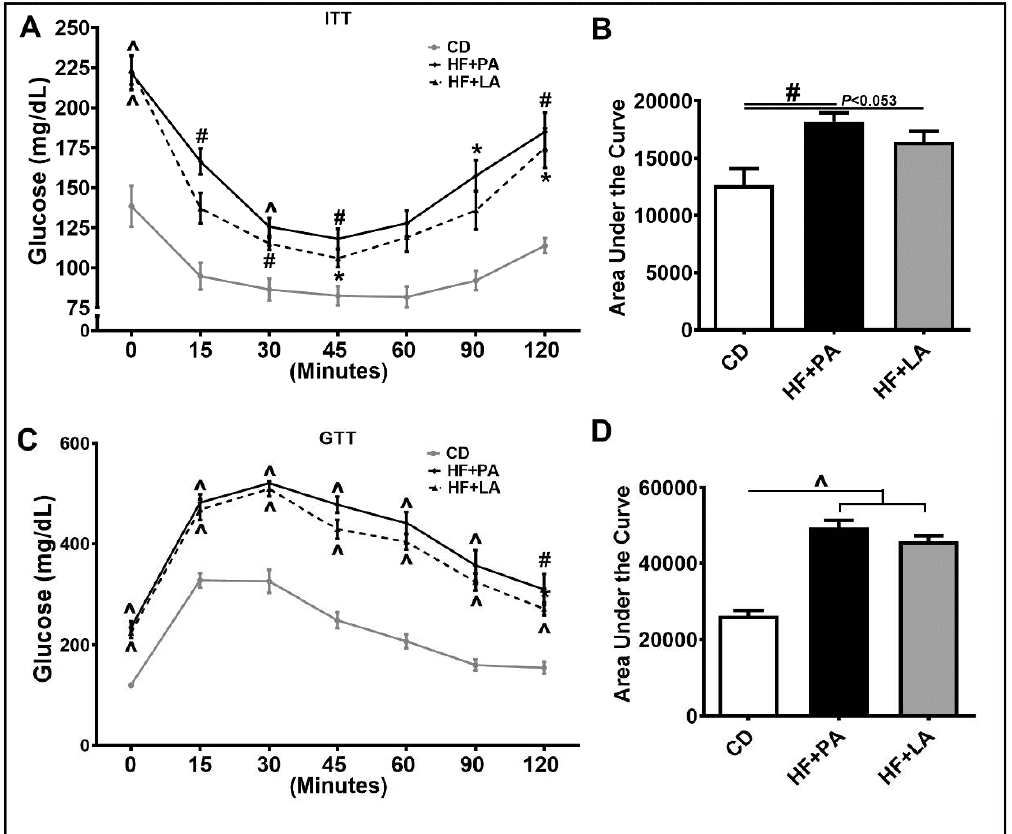
Figure 4. E ff ect of HF diet supplemented with PA or LA on systemic insulin resistance (IR). Mice were intraperitoneally injected with insulin for insulin tolerance test (ITT, A ) and glucose for glucose tolerance test (GTT) ( C ) and blood glucose was recorded at indicated time points ( A , C ). Area under the curve glucose values from ITT ( B ) and GTT ( D ) were determined. Values are expressed as mean ± SEM of 6–8 samples in each group. * p < 0.05, # p < 0.01, and ˆ p < 0.001 versus CD. CD, chow diet; HF + PA, high fat + palmitic acid; HF + LA, high fat + lauric acid.